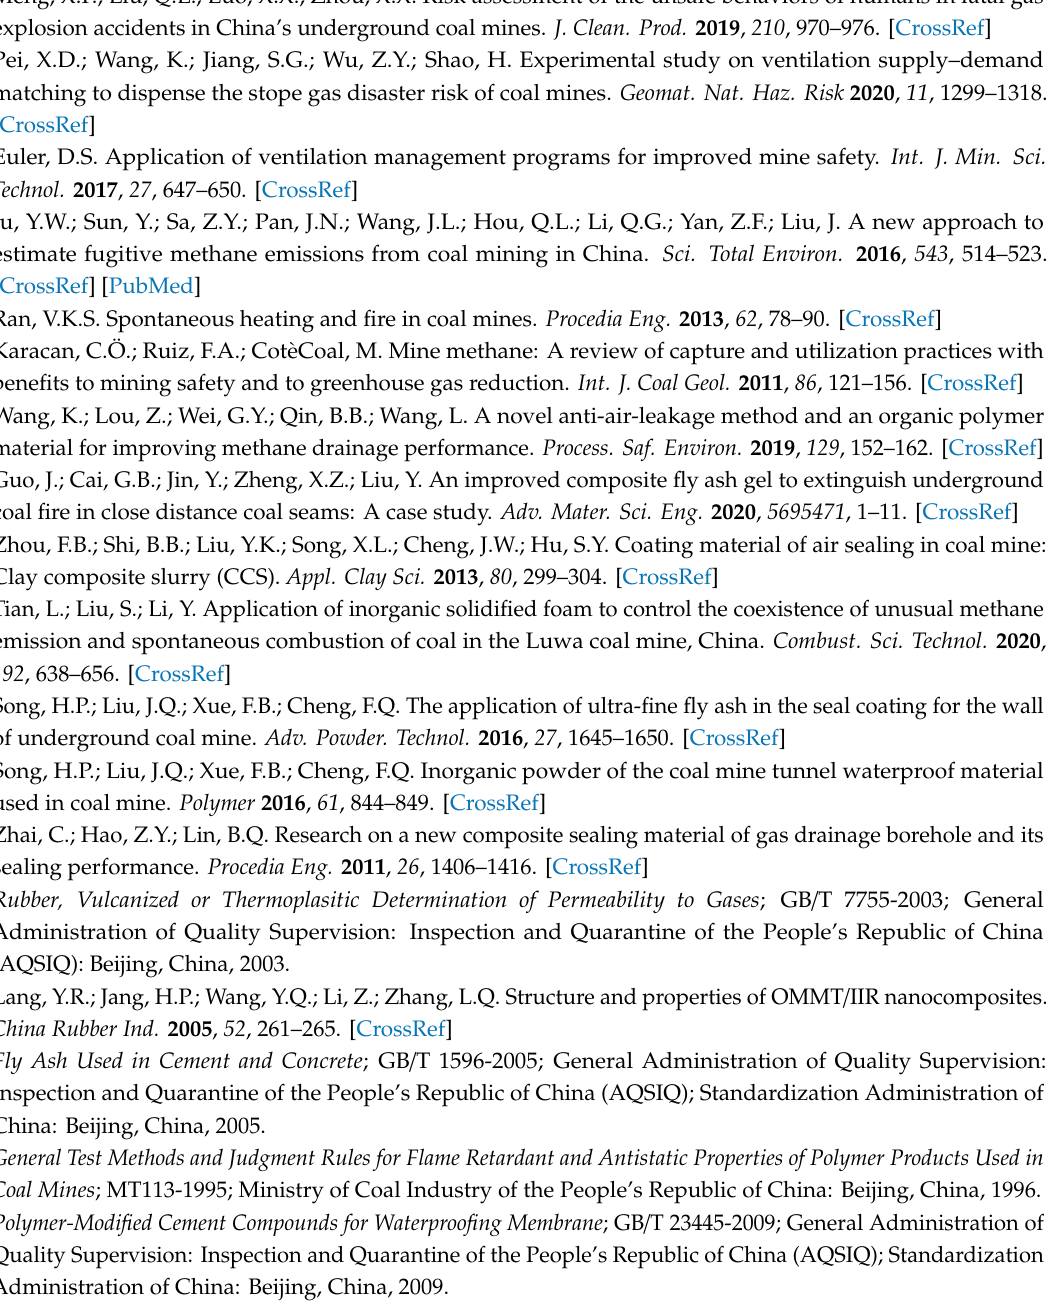
Table S1: Calculation table of permeability coe ffi